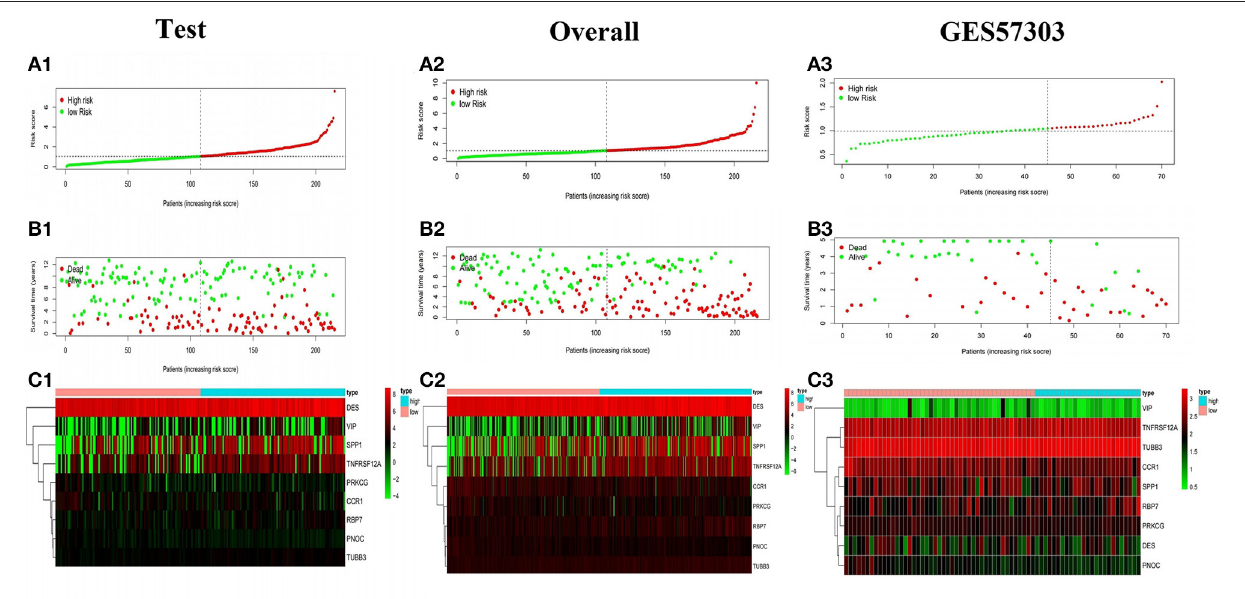
FIGURE 6 | Survival status of gastric cancer patients with different risk scores. The distribution of risk score (A1) , survival time (B1) , heat map (C1) of the test set. (A2,B2,C2, A3,B3,C3) The distribution of risk score, survival time, heat map of the overall internal validation set and GSE57303 external validation set.